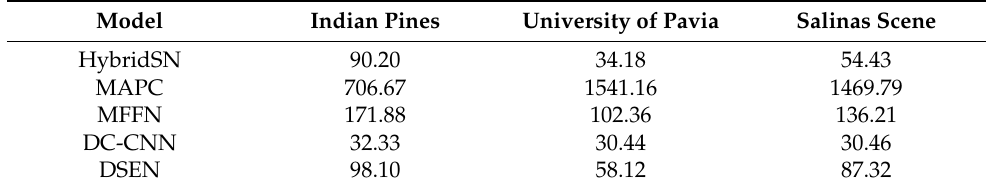
Table 6. Total Model Training and Testing Time (s).